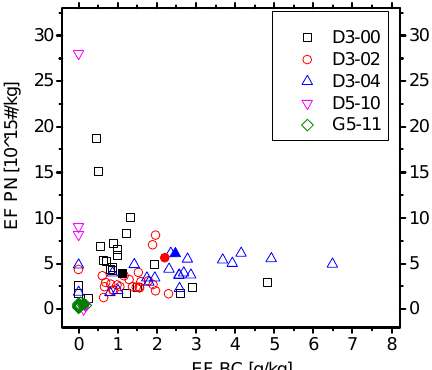
Figure 6. Particle number emission factors (PN EF) versus black carbon emission factors (BC EF) measured at the same vehicle drive-by. Empty symbols represent measurements with the station- ary method; full shapes denote the median of EFs measured with the chasing method. G5-11 and D5-10 overlap and thus the latter is not